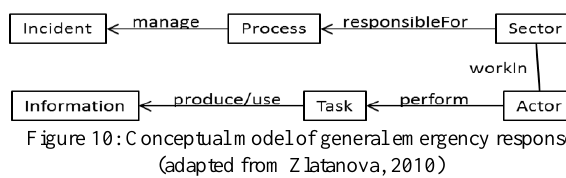
Figure 10: Conceptual model of general emergency response (adapted from Zlatanova,